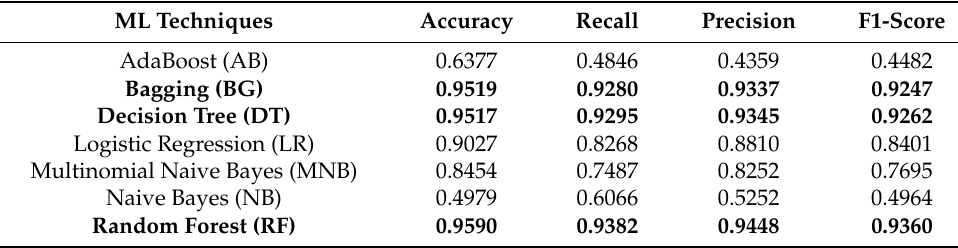
Table 8. The average metric scores of studies projects.